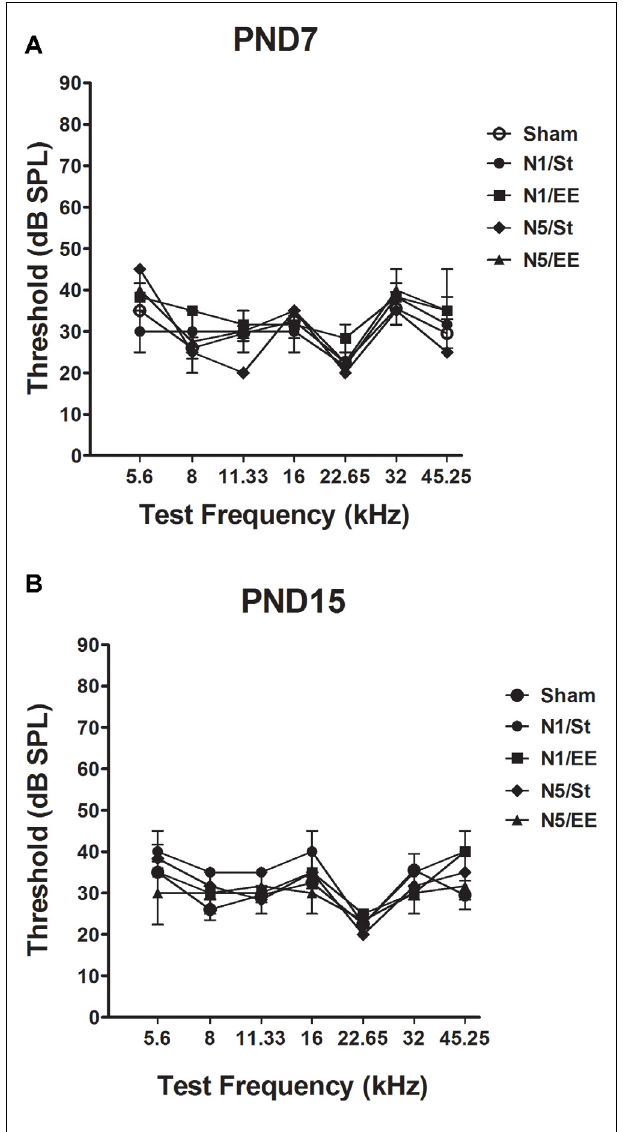
FIGURE 2 | Auditory brainstem responses (ABRs) in PND28 animals exposed at (A) PND7 and (B) PND15. Sham: non- exposed animals; N1: single noise exposure; N5: five-daily noise exposure. St: standard housing. EE: enriched environment. Data represent the mean ± standard error of the mean (SEM) of the ABR, n = 3 for each